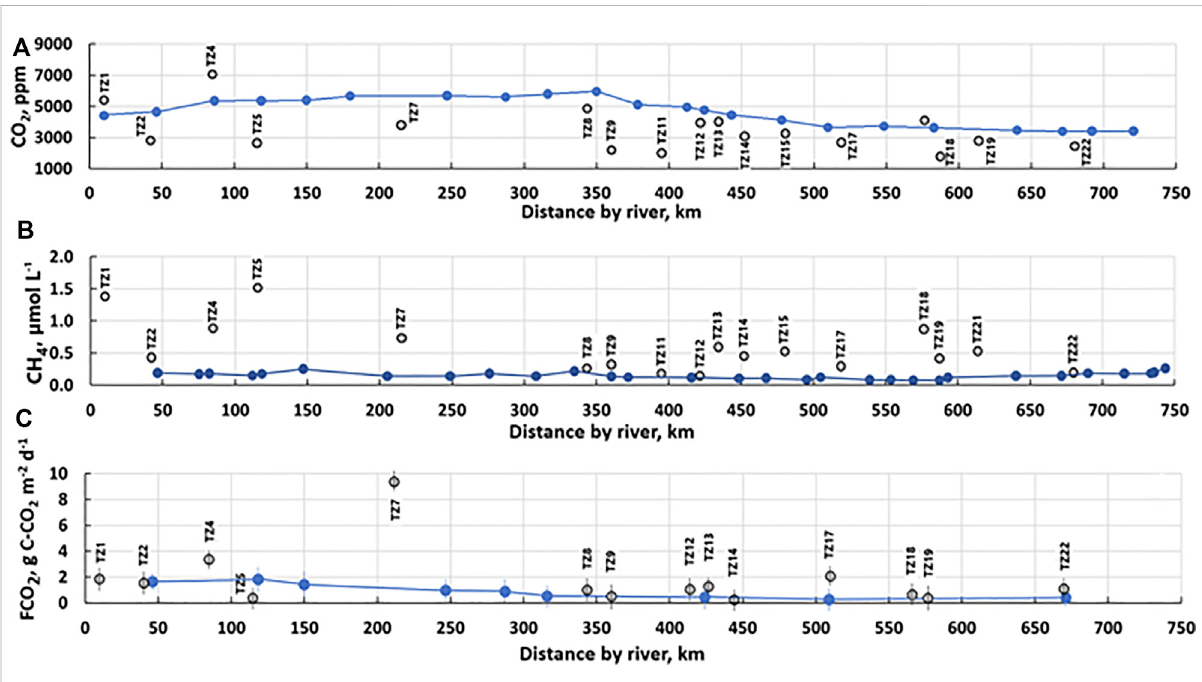
FIGURE 2 The CO 2 and CH 4 concentrations (A,B) and CO 2 fl uxes (C) pro fi le of the Taz River main stem (solid circles) and tributaries (open circles). See Figure 1 and Supplementary Table S1 for identi fi cation of tributaries number. Headwaters to the river mouth, from left to